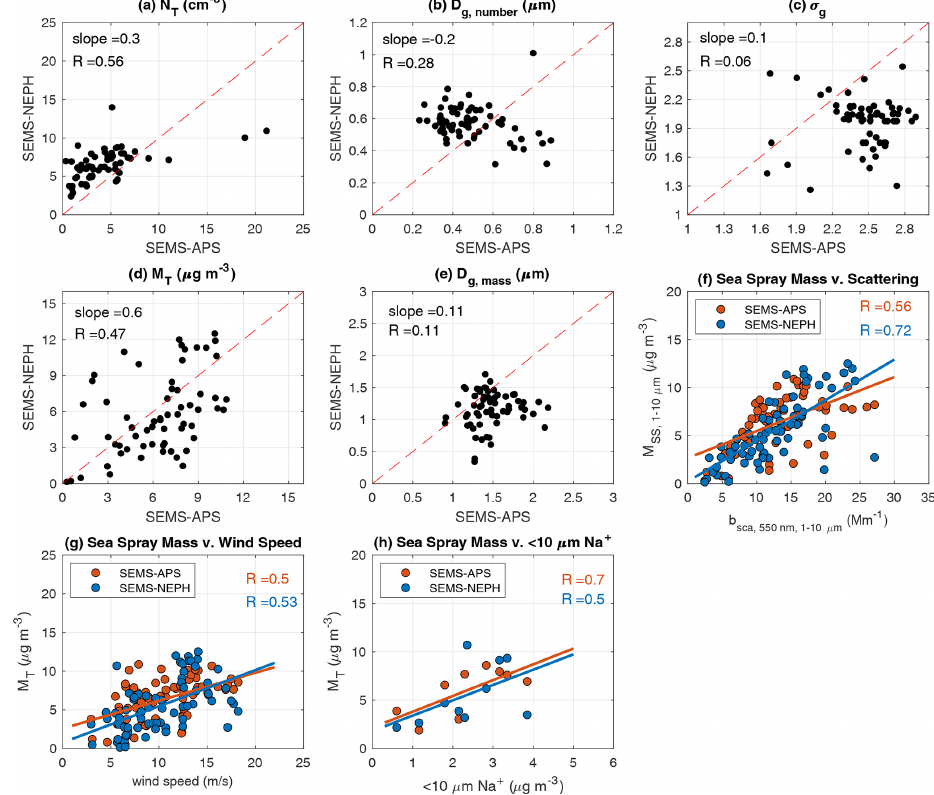
Figure 7. Comparison of sea spray modal parameters retrieved using measured supermicron size distributions (SEMS-APS; Saliba et al., 2019) and Mie inversion of nephelometer supermicron scattering (SEMS-NEPH; this study) during clean marine periods of the NAAMES 1 cruise (6 November–30 November 2015). Two-hour-integrated (a) number (cm − 3 ) and (d) mass (µgm − 3 ) concentrations, (b) number and (e) mass mean diameters (µm), and (c) mode widths are shown. Panels (a) – (e) also show the slope of linear best fit and the Pearson correlation coefficient at top left. Dashed red lines represent 1 : 1 lines. Sea spray mass correlations with supermicron scattering (f) , wind speed (g) , and < 10µm Na + mass concentration (h) for the SEMS-APS (orange) and SEMS-NEPH (blue) methods. Na + mass measurements are from offline filter analysis using ion chromatography. Sea spray mass estimates in (h) are averaged over the filter collection times (24h), which provided nine samples. Pearson correlation coefficients are indicated at top right and linear best fits are colored by method in (f) , (g) , (h) . Table 4. Comparison of sea spray modal parameters retrieved using measured supermicron size distributions (SEMS-APS; Saliba et al., 2019) and Mie inversion of nephelometer supermicron scattering (SEMS-NEPH; this study) during clean marine periods of the NAAMES ( D g , number ) , mass mean diameter ( D g , mass ) , and mode width ( σ g ) are provided as the mean ± 1 standard